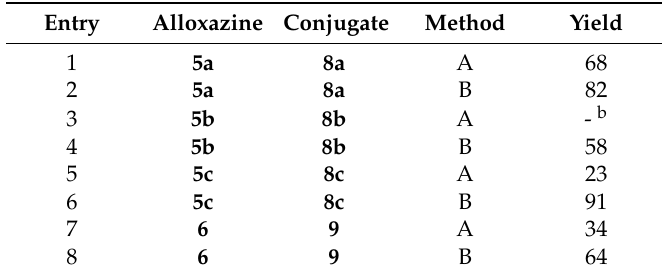
Table 1. Click reaction between flavins 5 or 6 and azidocyclodextrin 7 a .